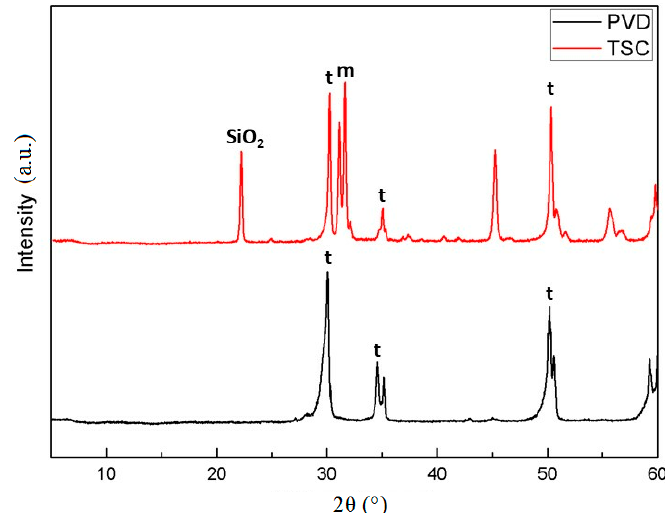
Figure 6. XRD patterns of TSC and PVD. No t → m phase transformation was detected in PVD-coated zirconia sample.